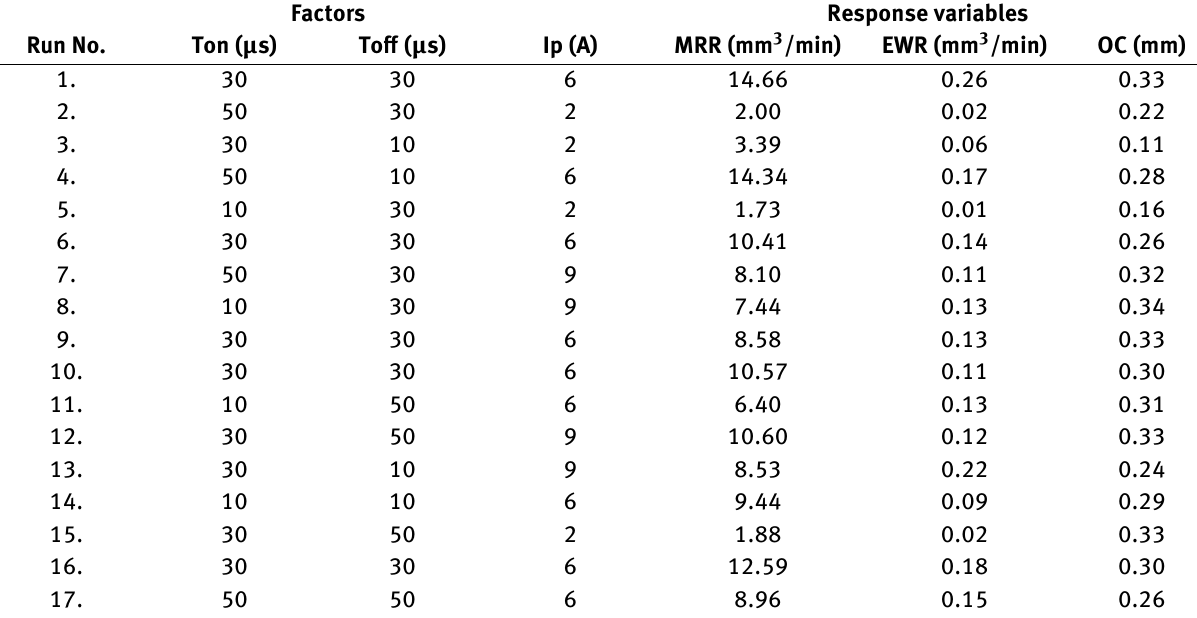
Table 3: Experimental design and results Factors Response variables